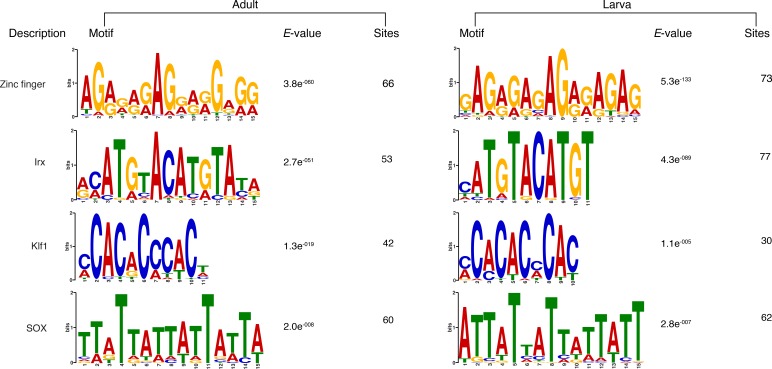
Matching sequence logos of the DNA motifs determined by MEME-ChIP analysis to be significantly enriched in the predicted activated enhancer-like sequences in both adult and larva.The E-value (log likelihood ratio of each motif) and the number of sites contributing to the construction of the motif are shown, respectively.